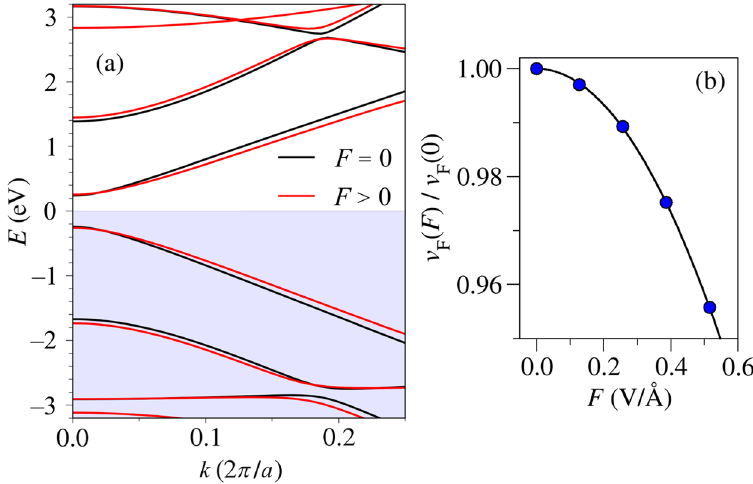
Figure 4. ( a ) DFT-calculated band structure of an N = 5 aGNR with (red) and without (black) a transversal electric field F = 0.51 V/Å. ( b ) Variation of the Fermi velocity of the first conduction band as a function of the electric field. We have considered the slope for the linear bands between k ~ 0.1 × 2 π / a and k ~ 0.2 × 2 π / a